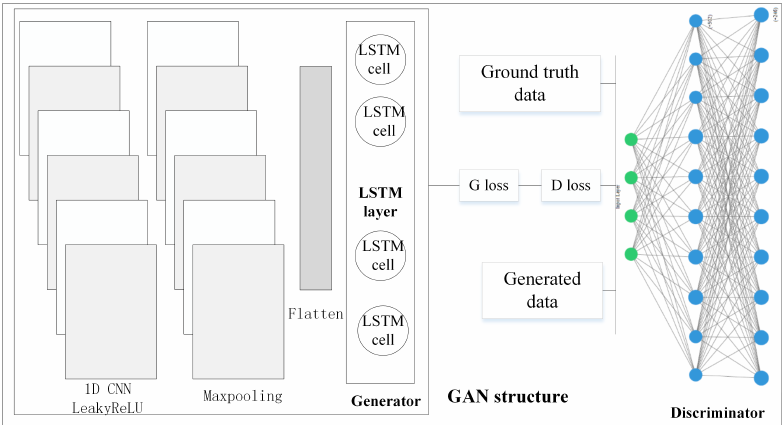
Figure 9. GAN structure for time series forecasting